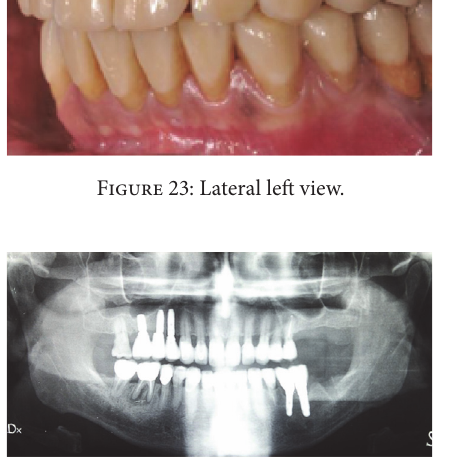
Figure 24: Final case, full-mouth intraoral radiographic